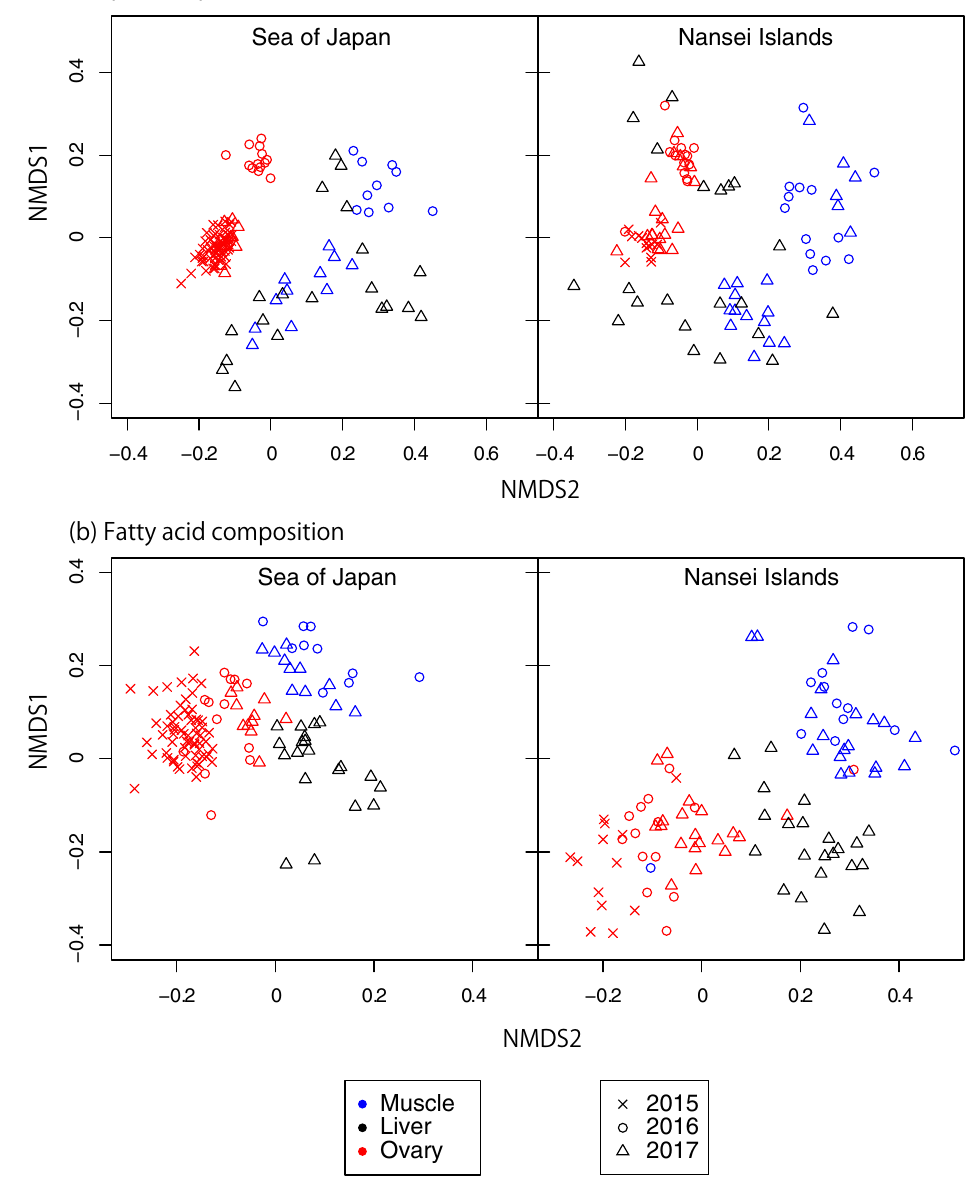
Fig 5. Non-metric multidimensional scaling (NMDS) plot of lipid (a) and fatty acid (b) compositions in ovary, muscle and liver tissues of female Pacific bluefin tuna caught around the Nansei Islands and in the Sea of Japan (two-dimensional stress = 0.16 and 0.17 for lipid and fatty acid compositions, respectively).